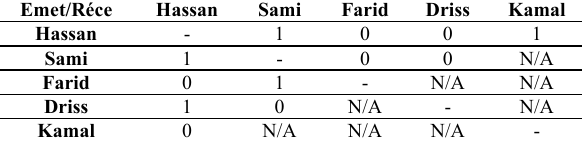
TABLE VI R ESULTS OF SHARING A « S TATUS » PUBLICATION B EFORE USING S2AF